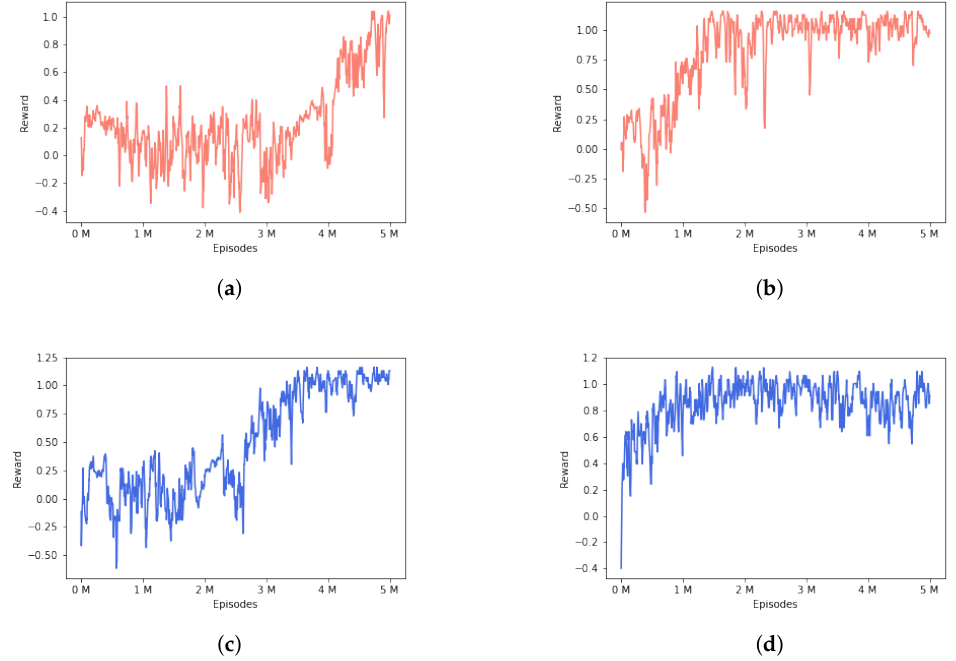
Figure 9. Episodes mean rewards. Comparison between the two approaches described in the paper: with ( right ) and without ( left ) features extractor module. The red charts correspond to the first training phase and the blue charts corresponds to the second training phase. ( a ) One-phase PPO episodes mean reward with adversaries in one lane. No features extractor layer. ( b ) One-phase FEPPO episodes mean reward with adversaries in one lane. Features extractor layer. ( c ) Two-phase PPO episodes mean reward with adversaries in two lanes. No features extractor layer. ( d ) Two-phase FEPPO episodes mean reward with adversaries in two lanes. Features extractor